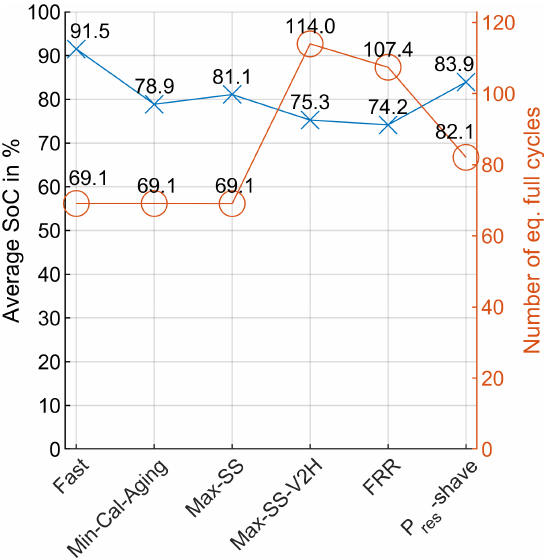
Figure 13. Average SoC and number of equivalent full cycles for scenario home charging H , mobility profile Worker and without SoC V 2 XLimit